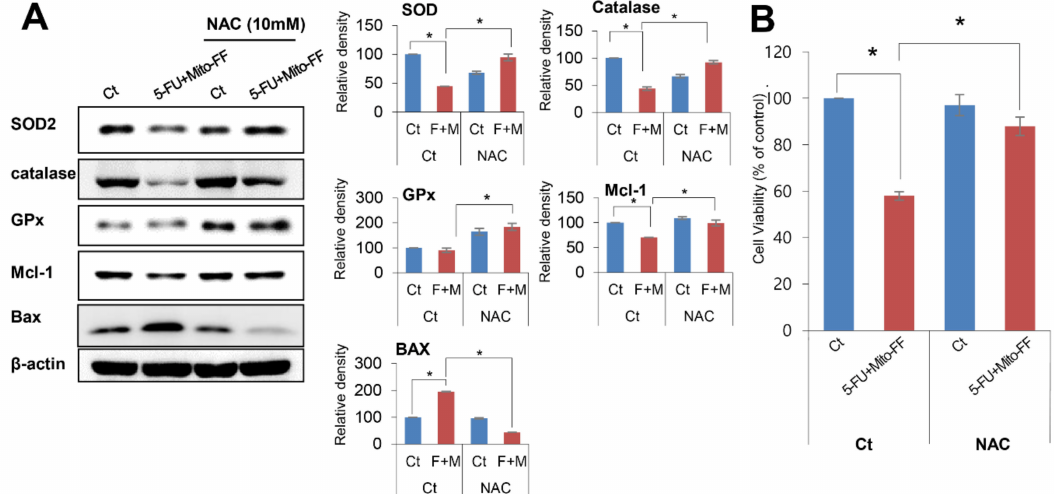
Figure 6. Inhibition test for the determination of the mechanism of action of combination therapy. ( A ) [Left] The e ff ects of reactive oxygen species (ROS) inhibition on the expression of proteins related with antioxidant activity and apoptosis in AGS cells treated with combination therapy (5-FU plus Mito-FF). N-acetyl-L-cysteine (NAC) was used as a ROS inhibitor. [Right] Relative densities of these markers in each group. Although combination therapy led to the lower expression of antioxidant enzymes (SOD, catalase, and GPx) as well as pro-apoptotic tendencies, which were expressed by the higher expression of a pro-apoptotic marker (Bax) and the lower expression of an anti-apoptotic marker (Mcl-1), these e ff ects were significantly abrogated by NAC. ( B ) E ff ects of ROS inhibition on the cell proliferation of AGS cells treated with combination therapy. NAC significantly abrogated the anti-proliferative e ff ects of combination therapy ( P <